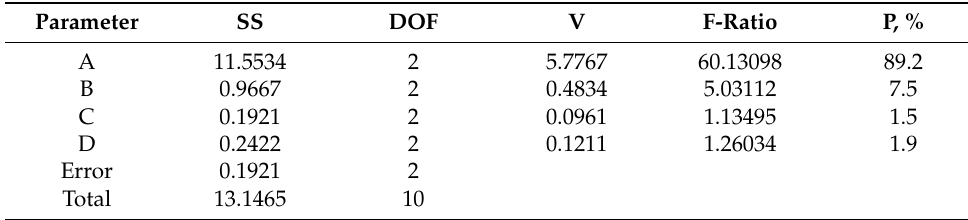
Figure 16. The mean S/N ratio for coefficient of friction. Table 14. Analysis of variance for coefficient of friction.